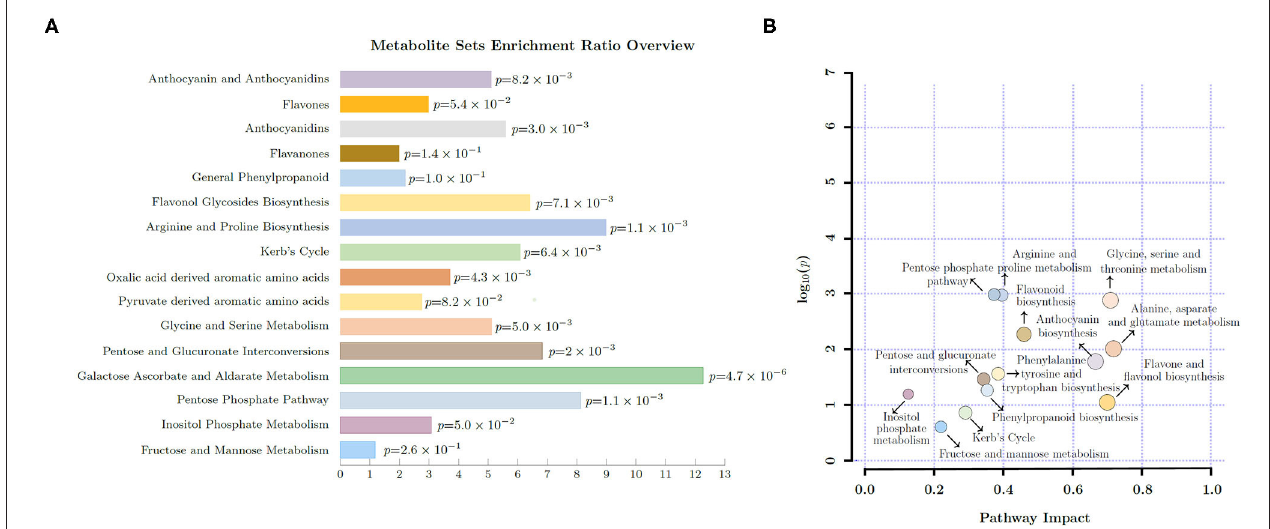
FIGURE 1 | Overview of enriched pathways (A) and pathway impact (B) in young shoots of Fengqing cultivar exposed to different light intensities and Phosphorous (P) levels.